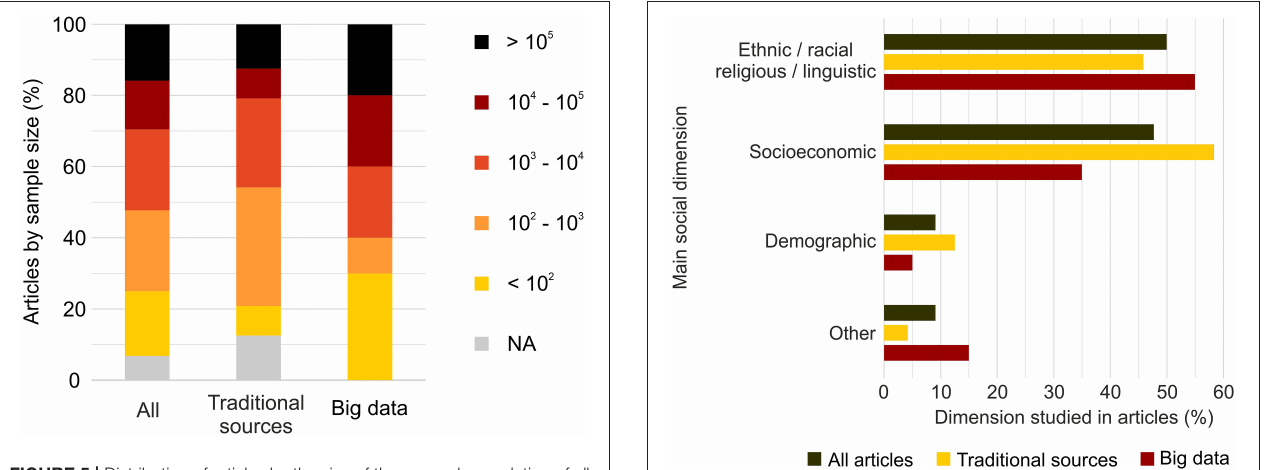
FIGURE 5 | Distribution of articles by the size of the research population of all activity space segregation studies ( n = 44), and separately of studies using traditional data sources ( n = 24) and big data sources ( n = 20).